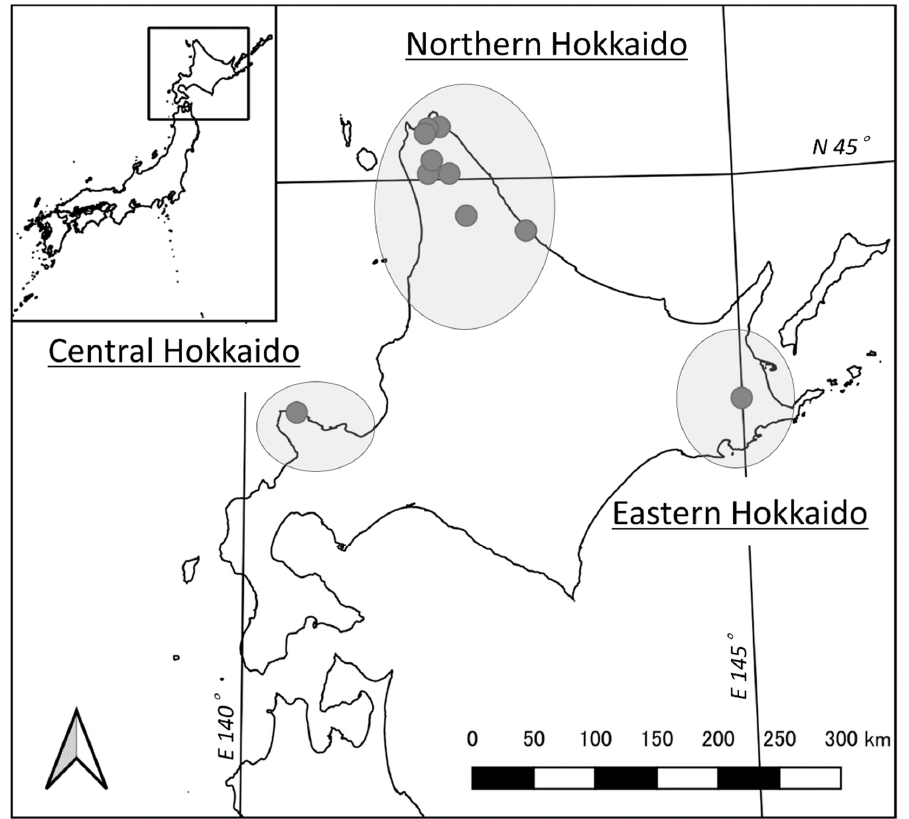
Figure 1. Locations of the study streams where quantitative sampling was performed (gray circles) and the sampling areas where mussels were collected for age estimation (circles) in Hokkaido. The name and specific locations of the study streams are withheld to protect the habitat of M. laevis .